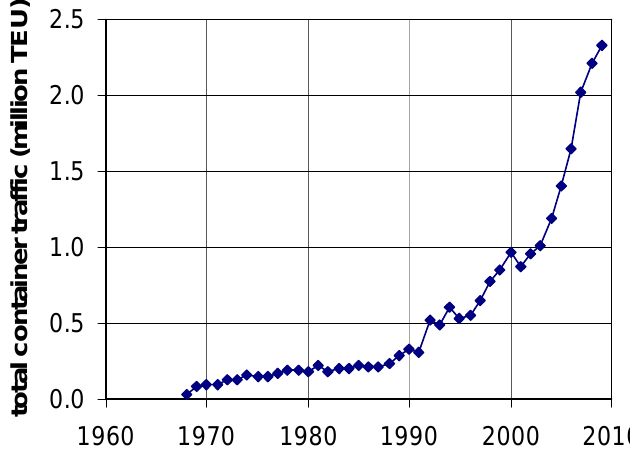
Figure 2. Port of Zeebrugge: evolution of container traffic 1968 – 2009 (Source: Port Authority Zeebrugge, 2009).